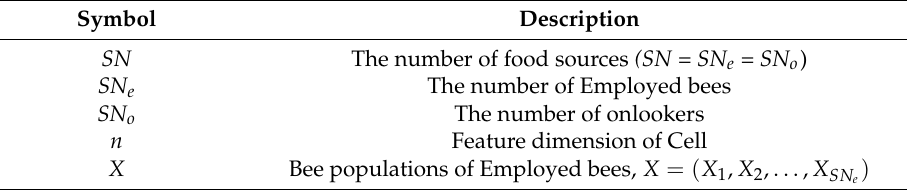
Table 1. The specific meaning of mathematical symbols in the optimization